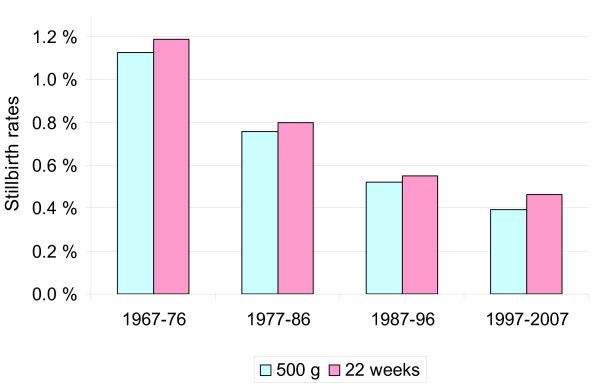
Stillbirth rates by reporting criteria. Norwegian stillbirth rates according to reports based on weight or gestational age. The data include 2.4 million births and 13,100 stillbirths in the Medical Birth Registry of the Norwegian Institute of Public Health.